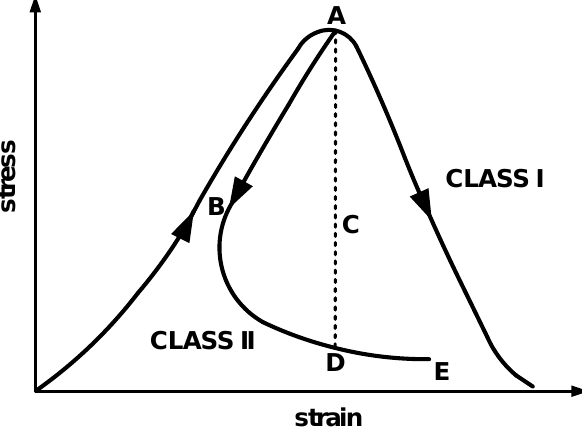
Figure 7. Rock failure behavior classification in uniaxial compression adapted from Wawersik (1968).